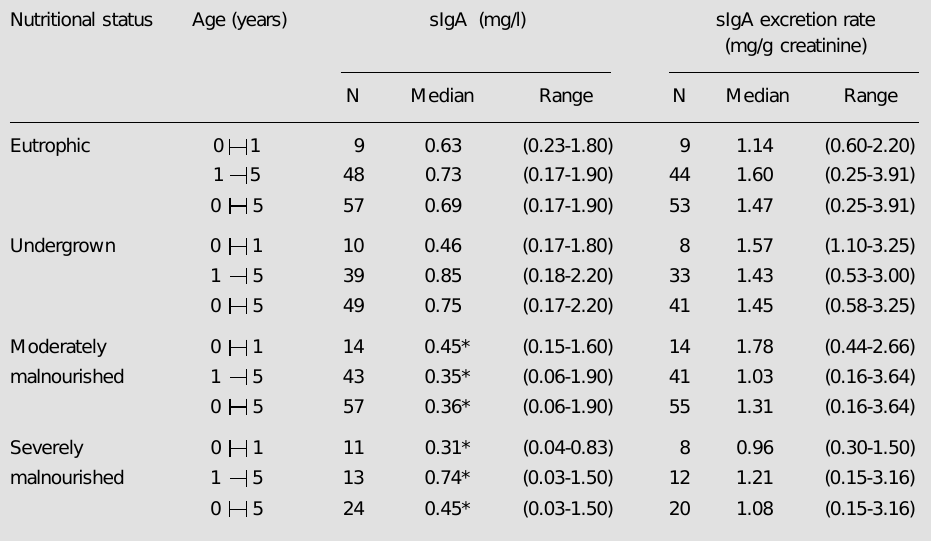
Table 3 - Median and range of urinary sIgA concentration and excretion rate in children of different nutritional